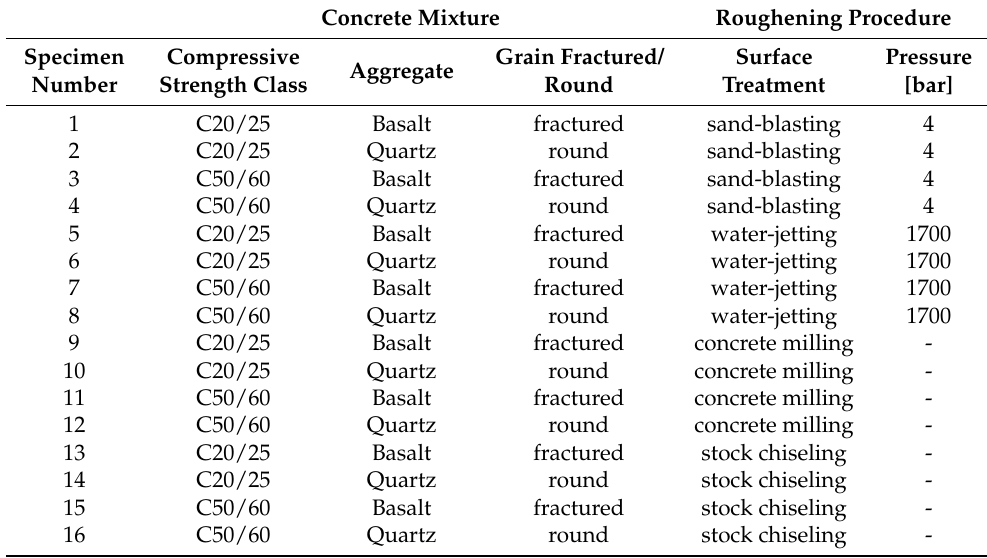
Table 4. Specifications of the 16 concrete specimens used as investigation objects for